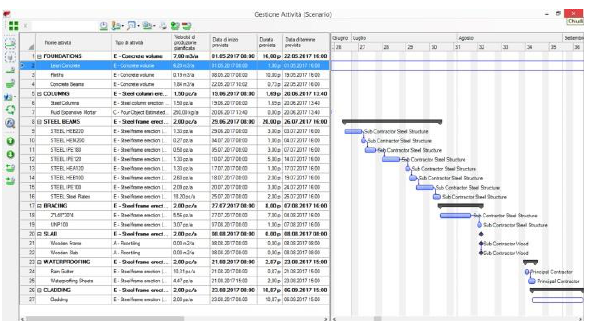
Figure 10. The Gantt chart in Tekla Structures